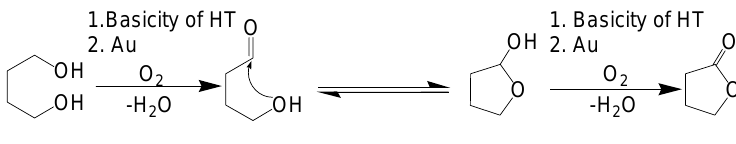
Figure 2. Lactonization Reaction Path.